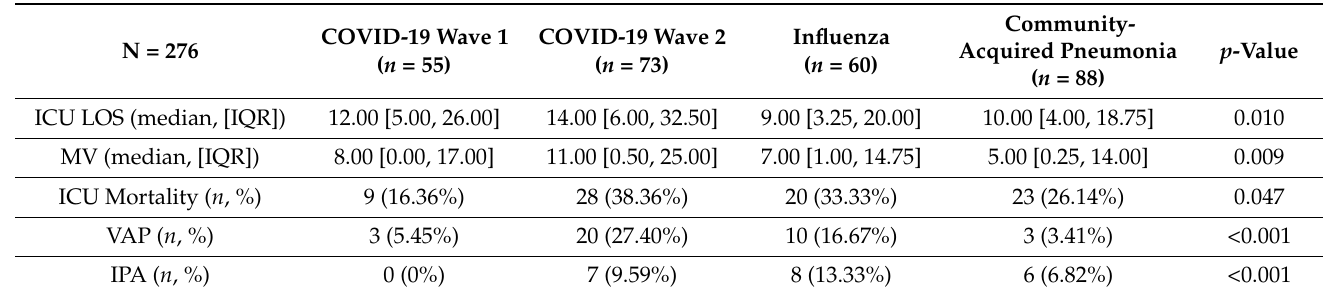
Table 2. Outcomes—length of stay, length of mechanical ventilation, ICU mortality, VAP, and